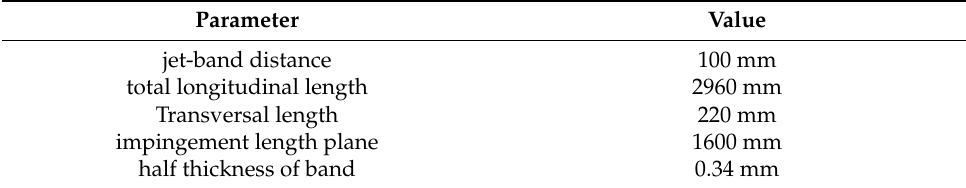
Table 7. Main parameters of the industrial